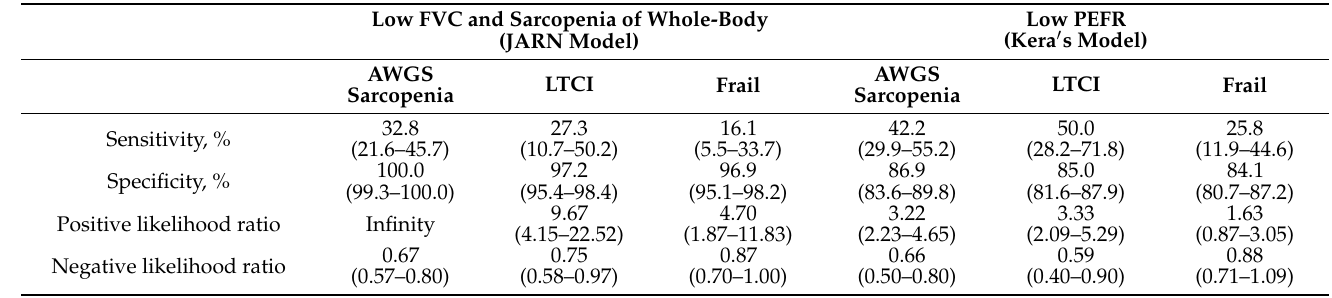
Table 4. Sensitivity and specificity of each type of respiratory sarcopenia for AWGS sarcopenia, LTCI, and frailty.